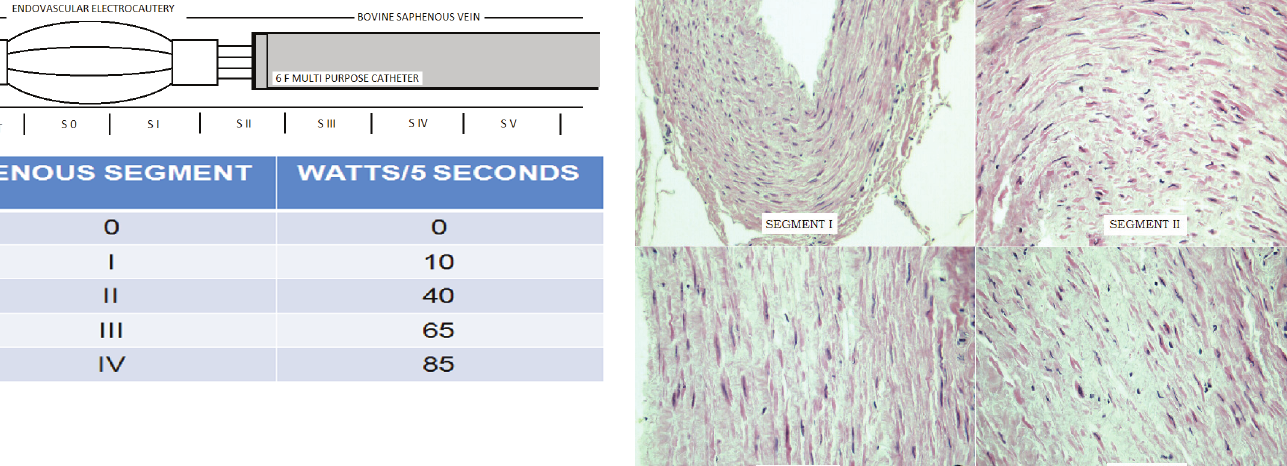
FIGuRE 4 - Hematoxylin and eosin (HE) microscopic analysis findings: segment I: HE 5X - Vascular wall with mild nuclear rarefaction. segment II: HE 20 X - Increase of cells with pyknotic nuclei and cytoplasm retraction. segment III: HE 40 X - Microscopic field with most of cellular nuclei with pyknotic alteration and cytoplasm retraction. segment IV: HE 40 X - Microscopic field with almost all of pyknotic nuclei and cytoplasm retracted. No microscopic electrocoagulation effect was found in the adjacent